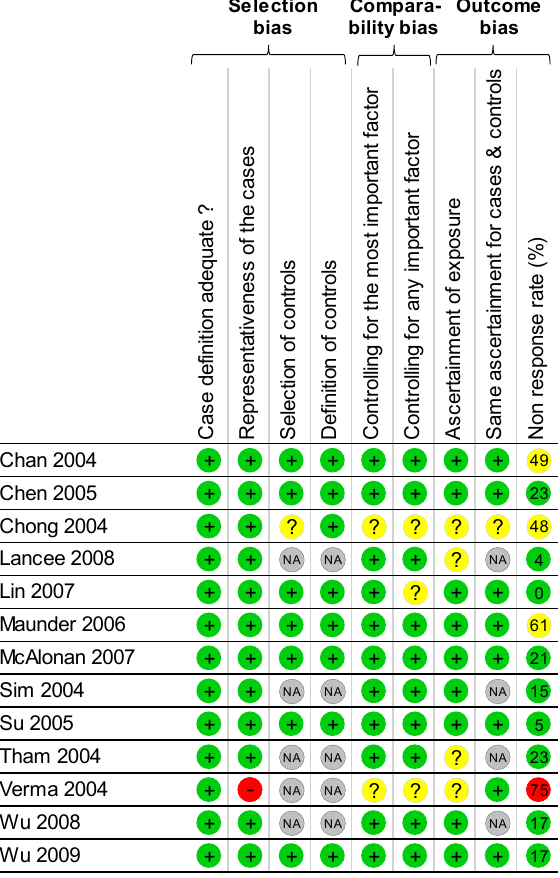
Figure A2. Quality of articles using the “STrength-ening the Reporting of OBservational studies in Epidemiology” (STROBE checklist).